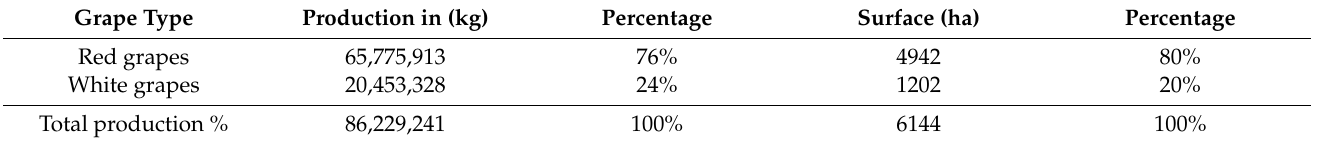
Table 4. Aggregate grape production by typology in